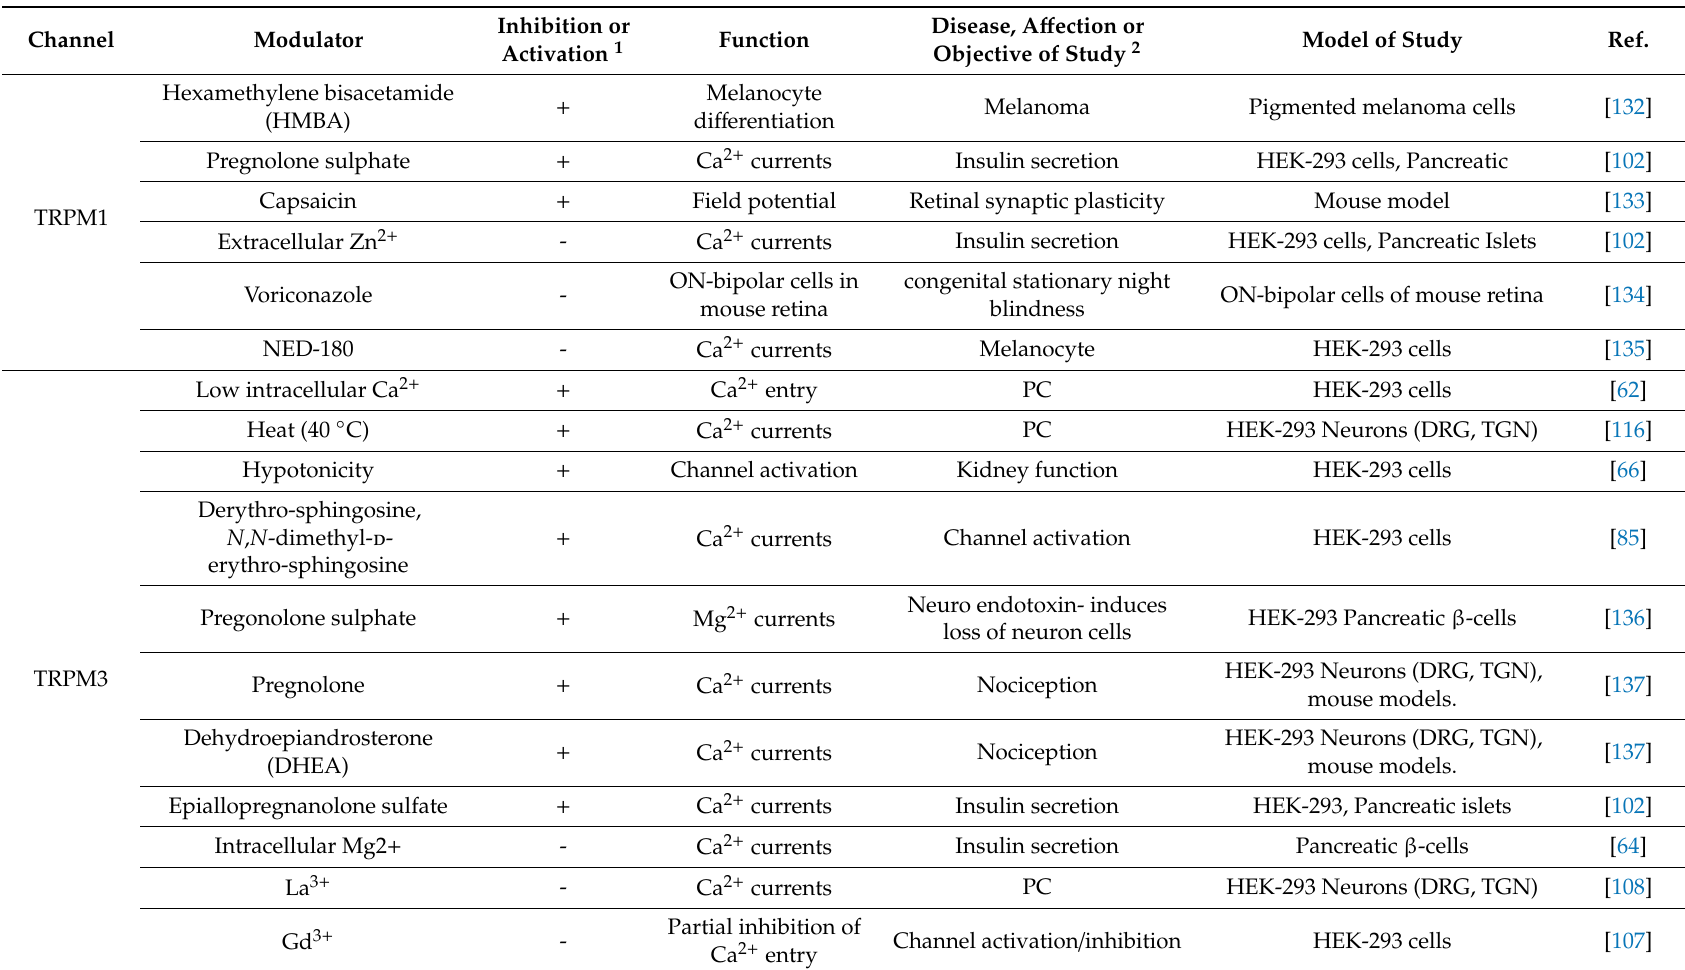
Table 1. Molecules modulating the activity of TRPM1 and TRPM3, participation in physiological processes and